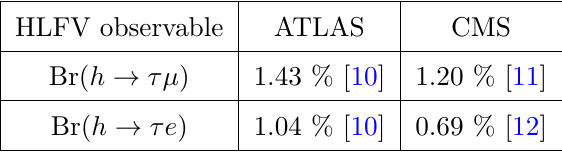
Table 1. Experimental 95 % C.L. upper bounds on HLFV decays from ATLAS and CMS in the tau sector using the 13 TeV data sets. In our numerical scan, we will use the strongest upper bounds from CMS shown in this